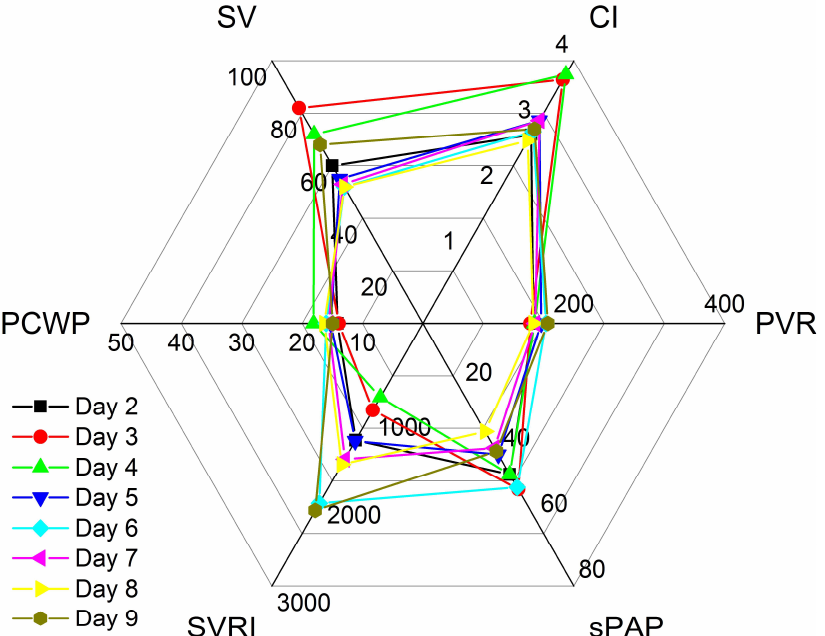
Figure 5. Haemodynamic profiling after heart transplantation. Haemodynamic profiles of patient #5 on different days of intensive care therapy. CI: cardiac index [L · min − 1 · m − 2 ]; SV: stroke volume [mL]; PCWP: pulmonary capillary wedge pressure [mmHg]; SVRI: systemic vascular resistance index [dyn · s · cm − 5 · m − 2 ]; sPAP: systolic pulmonary artery pressure [mmHg]; PVR: pulmonary vascular